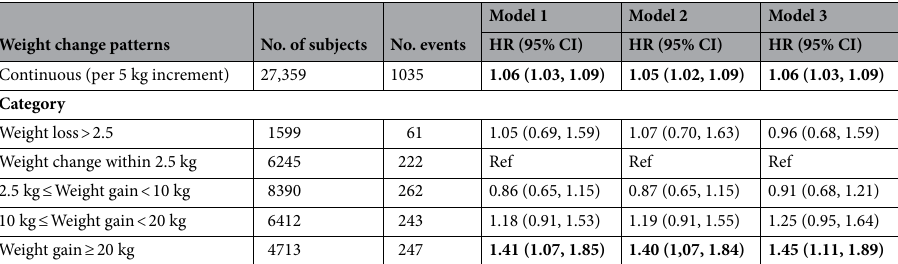
Table 5. Hazard ratios (HRs) and 95% confidence intervals (CIs) of incident asthma with absolute weight change patterns across adulthood. All estimates accounted for complex survey designs and the analyses used the sample weights, stratification and clustering suggested by the CDC. Significant results are in boldface type. Model 1: Non-adjusted model. Model 2: Adjusted for age at 10 years before baseline, gender, race/ethnicity (Mexican American, non-Hispanic White, non-Hispanic Black, and other race). Model 3: Adjusted for age at 10 years before baseline, gender, race/ethnicity (Mexican American, non-Hispanic White, non-Hispanic Black, and other race), baseline education level (less than high school, high school or equivalent, college or above), baseline family income (family income-poverty ratio, 0–1.0, 1.1–3.0, > 3.0), baseline smoking status (ever smoke and never